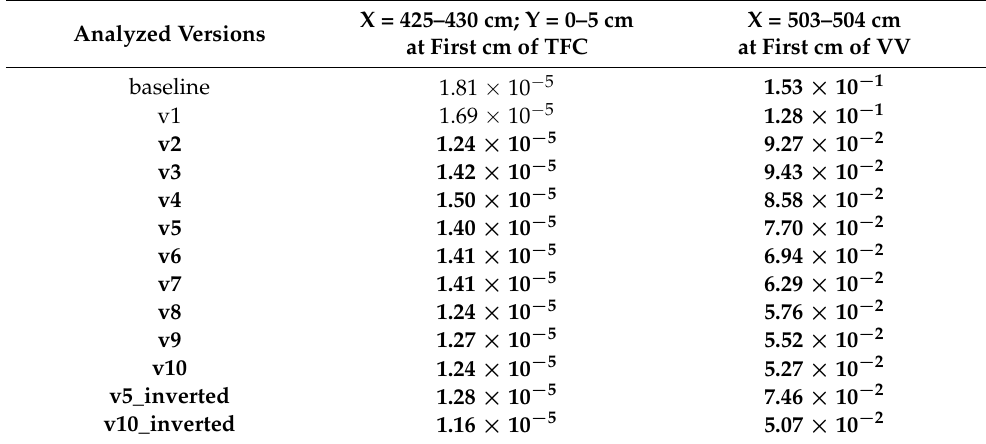
Table 4. Damage function (dpa/FPY) at first 5 cm of TFC and at the first cm of the VV for the baseline model, versions v1–v10, and v5_inverted and